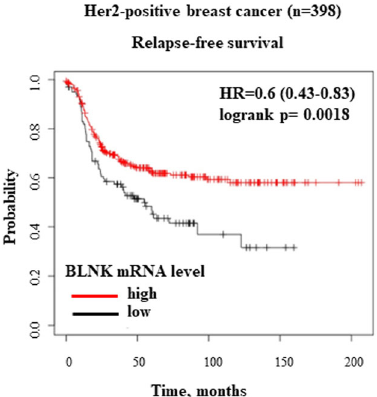
Cell Death and Disease (2022)